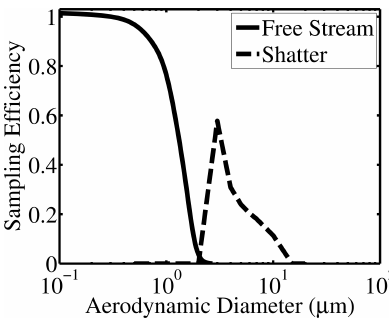
Figure 9. The cut size of the cross-flow sampling tube of BASE- II. Also shown is the size-dependent fraction of shatter particles that will be present in the sampling flow region of the cross-flow sampling inlet. Flight conditions are 400mbar and Ma 0.45; shatter particles were injected at a normal velocity of 10ms − 1